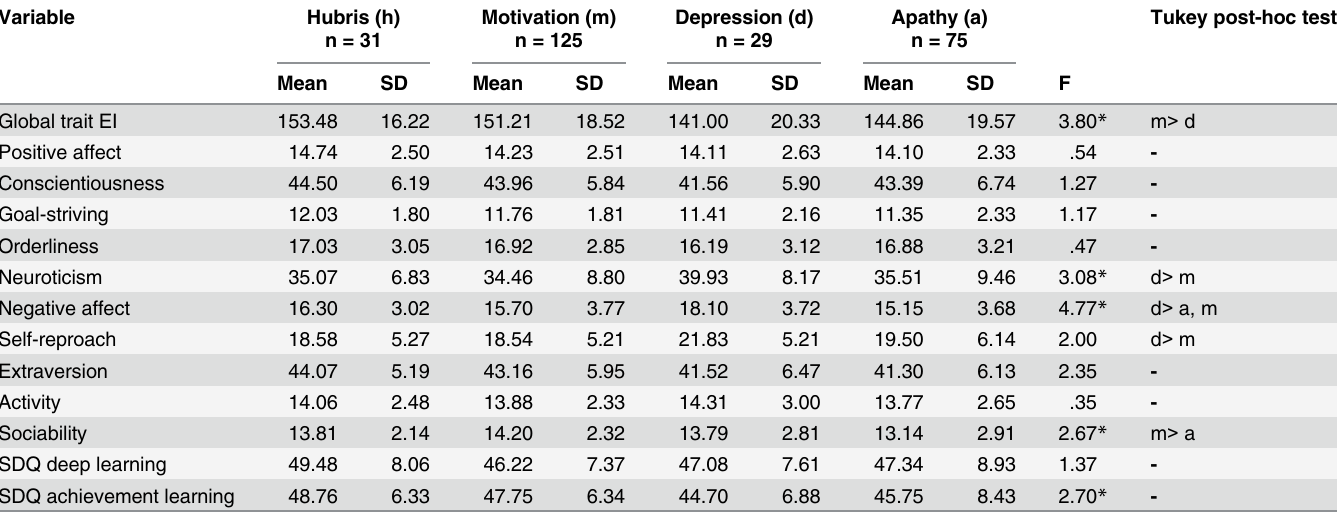
Table 4. Descriptive Statistics and One-Way ANOVA Results for the Friends Classification. Variable